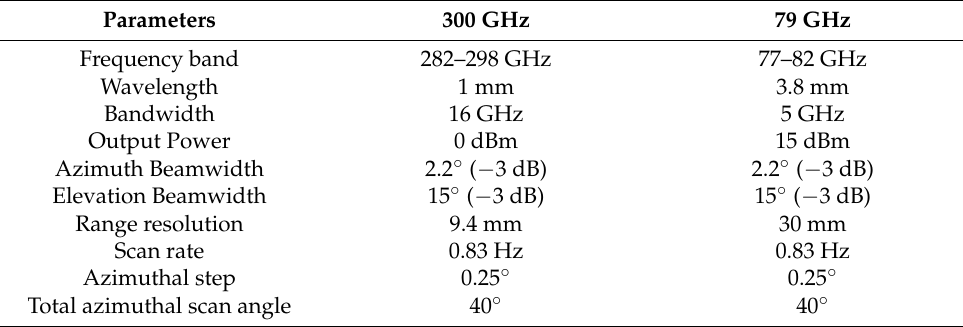
Table 1. Measurement system